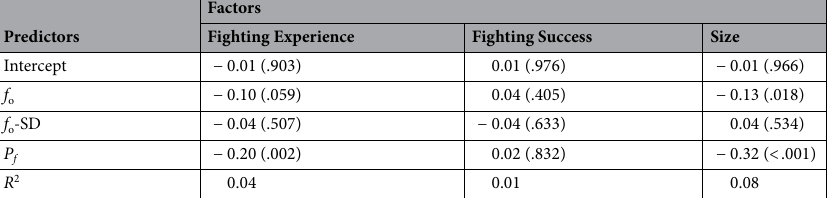
Table 2. Results of micro–macro multi-level models predicting three component measures of fight metrics from acoustic measures. Results are reported as effect size (p-value). Effect sizes are beta-weights, except for retirment status, which is odds ratio. In all models, the variance inflation factor (VIF) of each predictor was < 1.5. f o = fundamental frequency; f o -SD = Variability in fundamental frequency; P f = formant